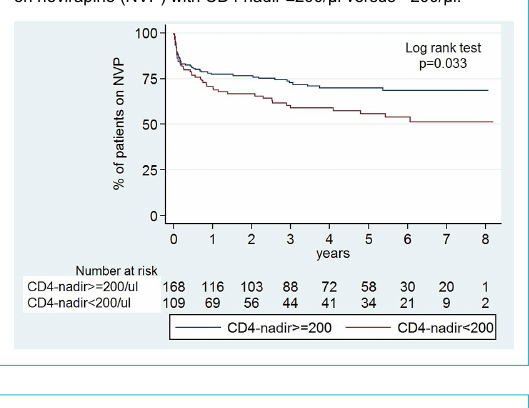
Figure 4: Kaplan-Meier survival curves: probability of remaining on nevirapine (NVP) with CD4 nadir ≥200/µl versus <200/µl.